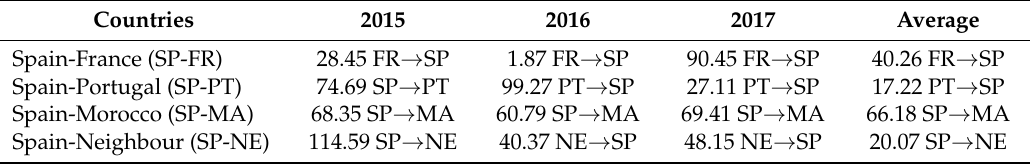
Table 2. Net annual ‘exchanges’ of renewable premiums (M € ) between interconnected